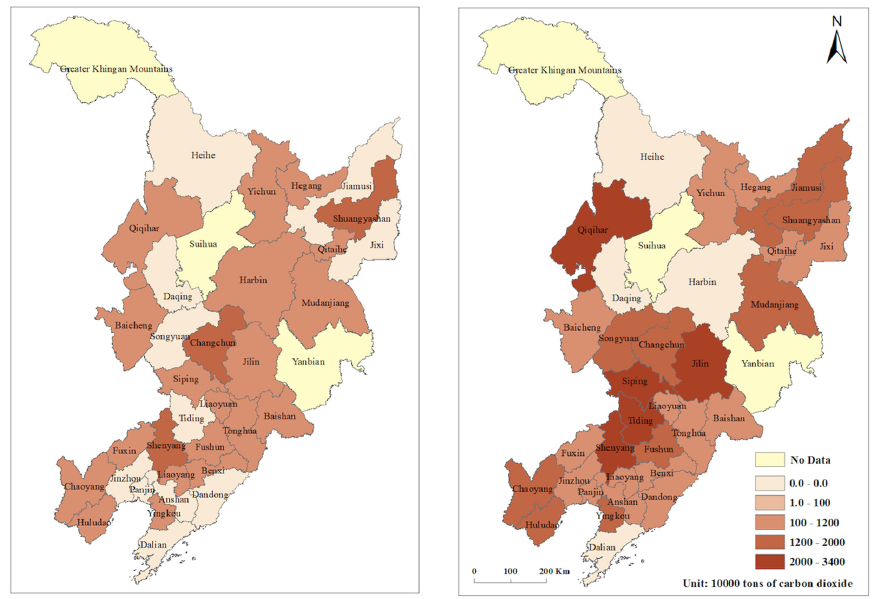
Figure 3. Potential carbon dioxide emission reduction (PCR) of prefecture–level cities in northeast China.